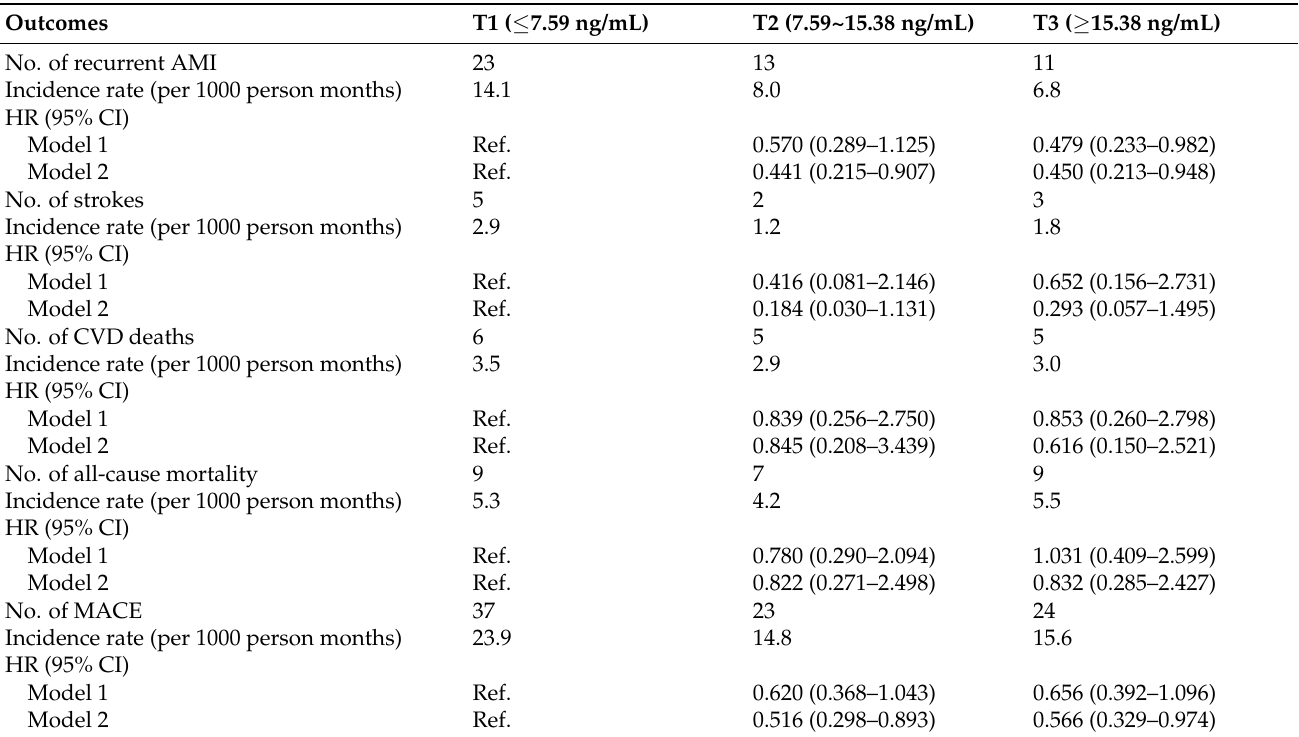
Table 3. Multivariable Cox regression analysis for recurrent AMI, strokes, CVD deaths, all-cause mortality, and